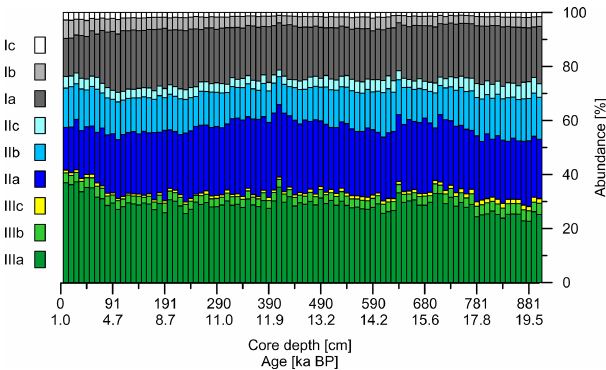
Figure 3. Fractional abundances of all nine brGDGT in core 12KL, given in percentage relative to the amount of (cid:54)